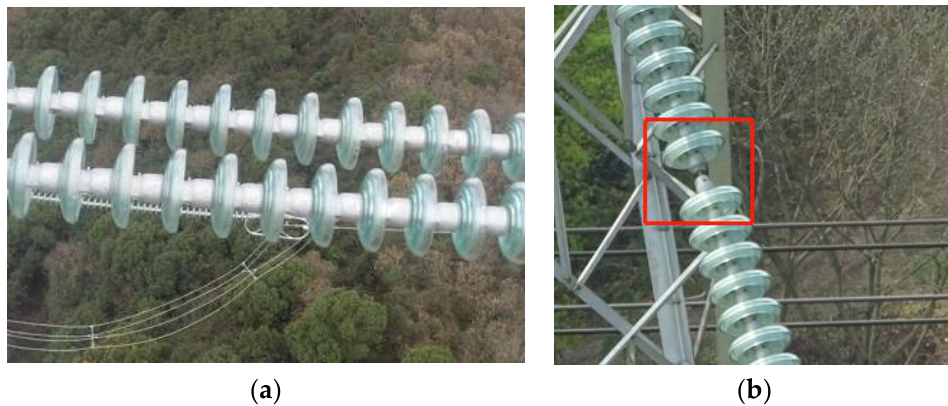
Figure 1. Insulators on high voltage transmission line: ( a ) Intact Insulator; ( b ) Defective Insulator.